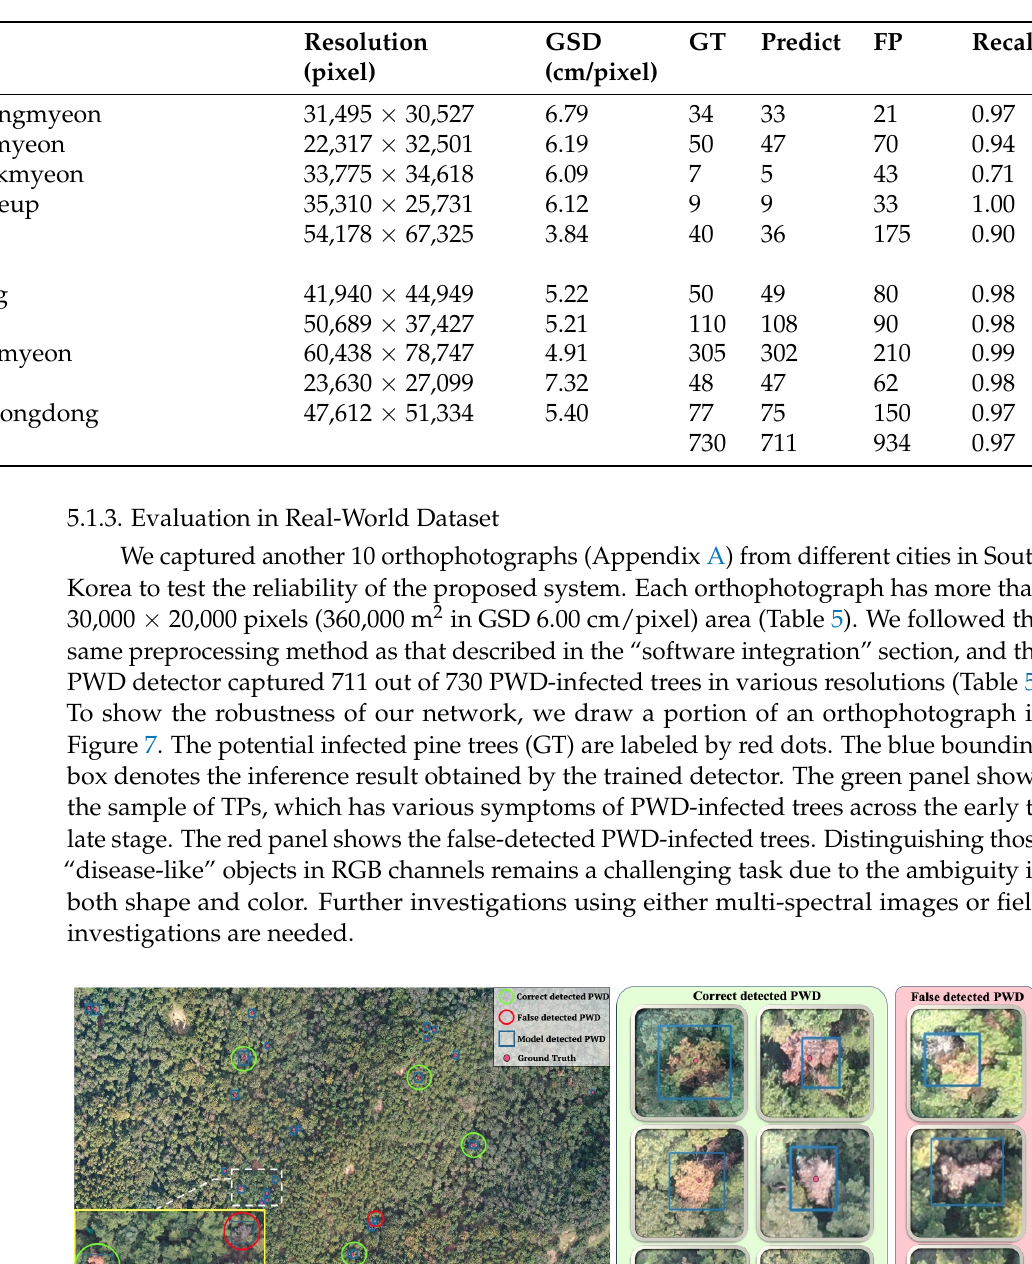
Table 5. Real environment evaluation results.